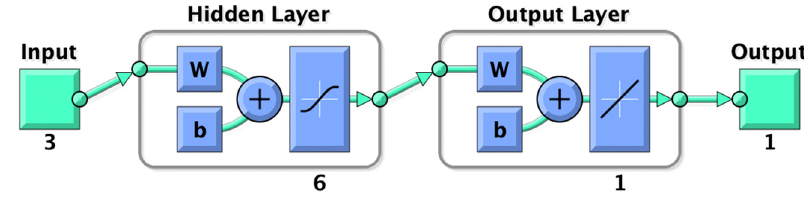
Figure 1. Structure of ANN.